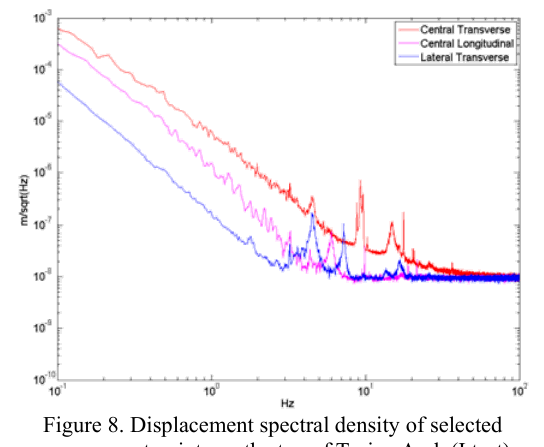
Figure 8. Displacement spectral density of selected measurement points on the top of Trajan Arch (I test).